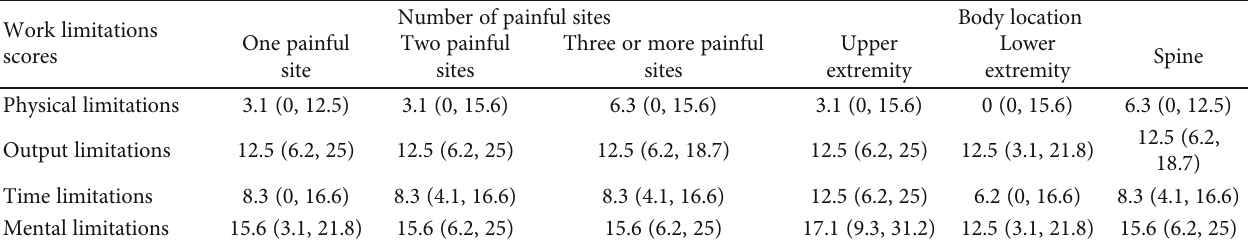
Table 2: Median and interquartile range (IQR) work limitation scores for the number or body location of painful sites.